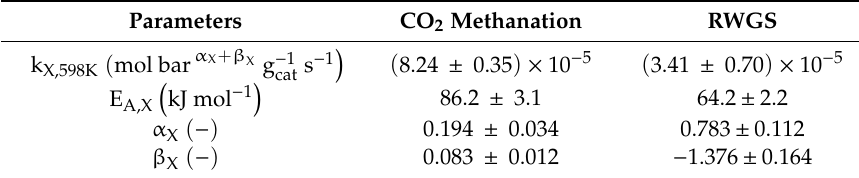
Figure 7. Parity plot for the power-law kinetic models. Table 5. Power-law expressions regression results.